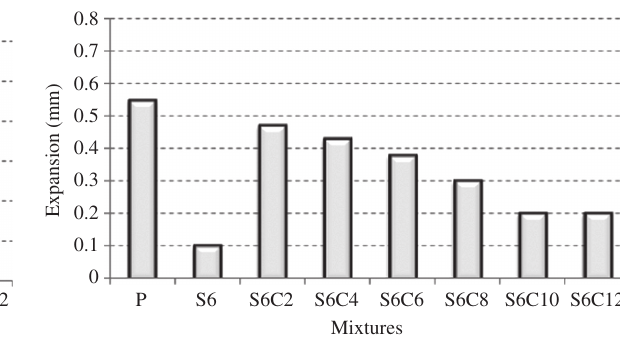
Figure 4 Specific gravities of